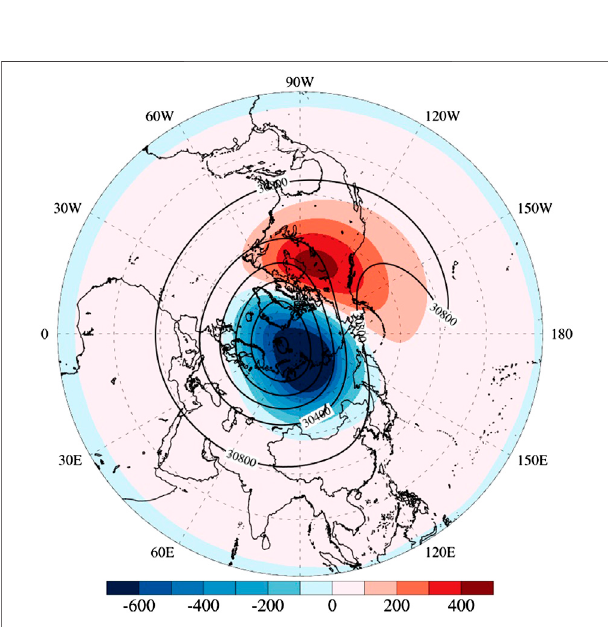
FIGURE 7 | Spatial distributions of climatological DJF mean 10 hPa geopotential height (contour, unit: m) and 2019/2020 DJF mean 10 hPa geopotential height anomalies (shaded, unit: